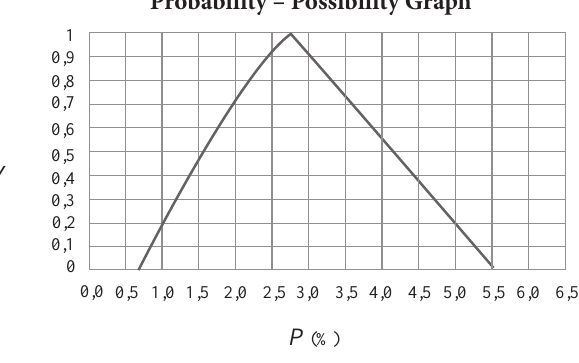
Fig. 4. The possibilities of probabilities P (Profit >